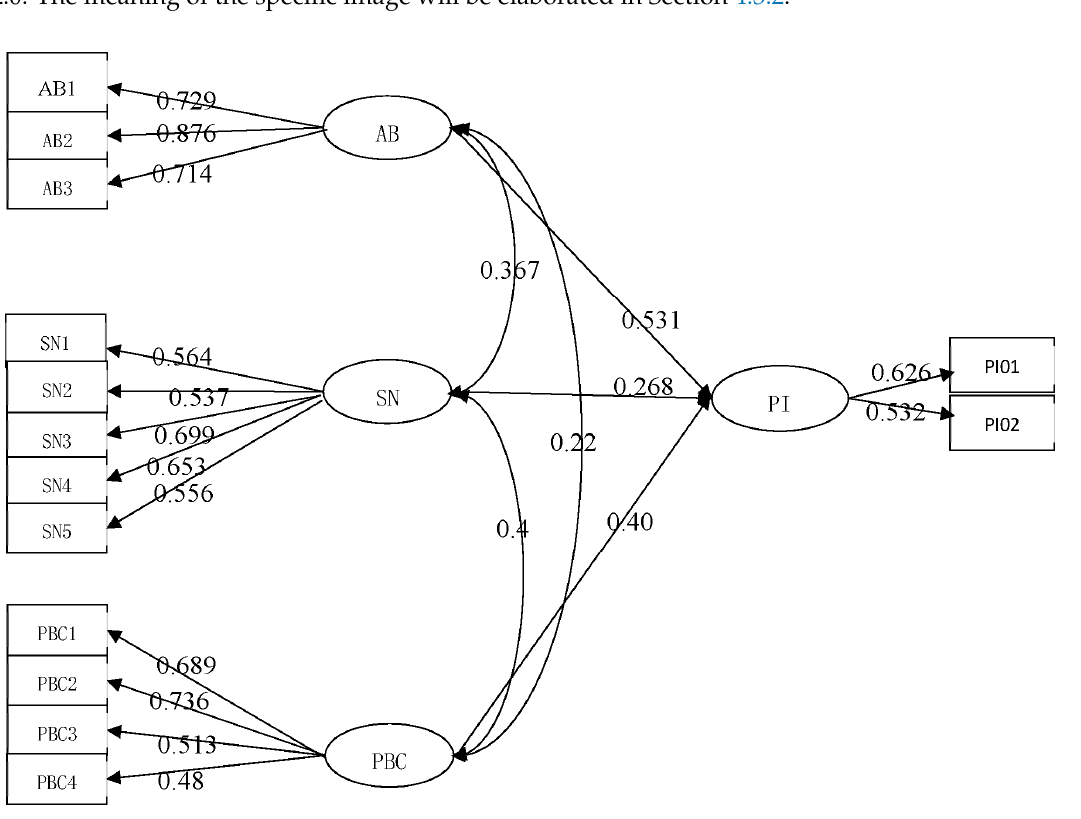
Figure 1. Structural equation model variable regression path coefficient graph.